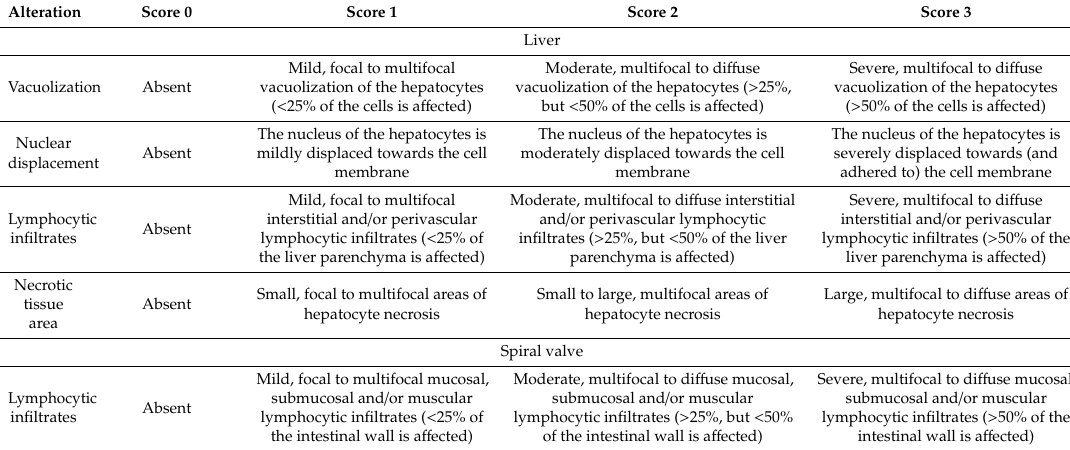
Table 2. Semi quantitative scoring system adopted for the assessment of the liver and the intestinal histological